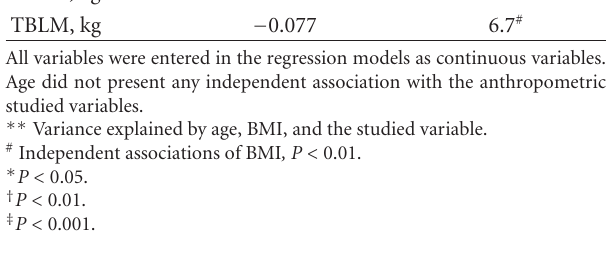
Table 4: Independent contributions (standardized beta coe ffi - cients) of abdominal adipose tissue depots and thigh body compo- sition compartments to liver-to-spleen ratio, adjusted for age